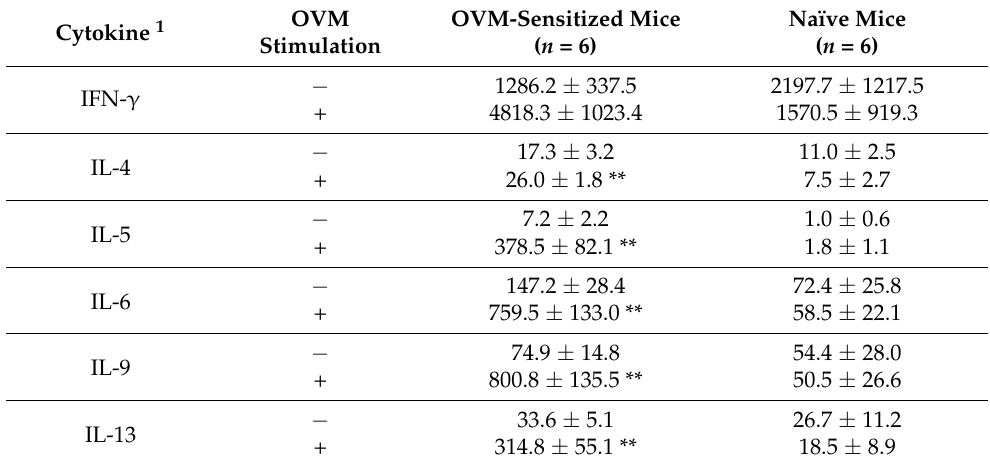
Table 1. Cytokine levels in culture media of splenocytes stimulated with (+) or without ( − )